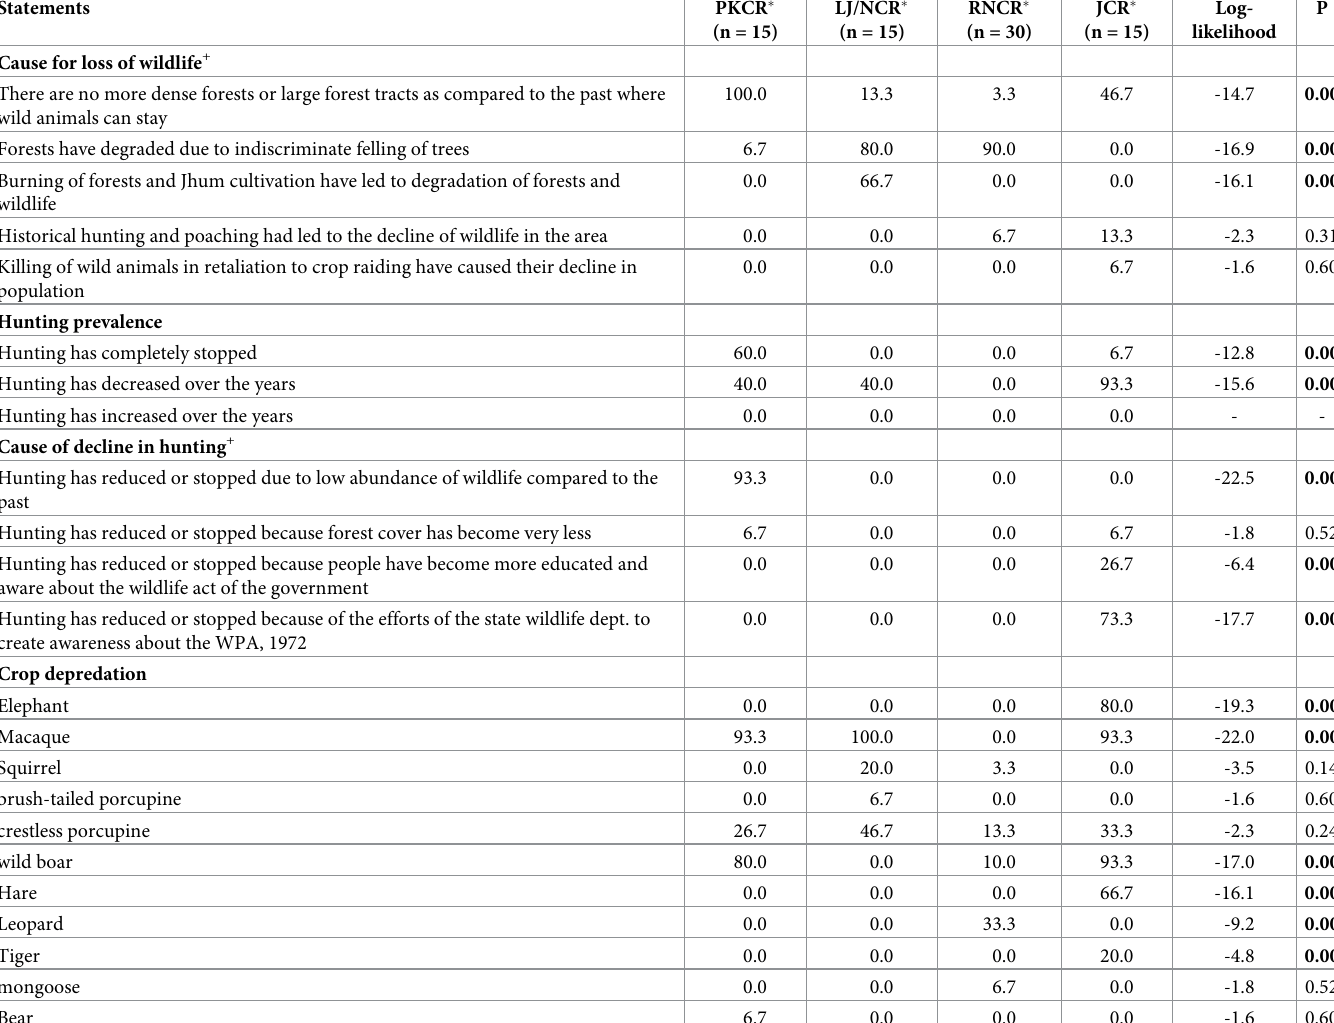
Table 3. Locals (n = 75) views on wildlife and hunting